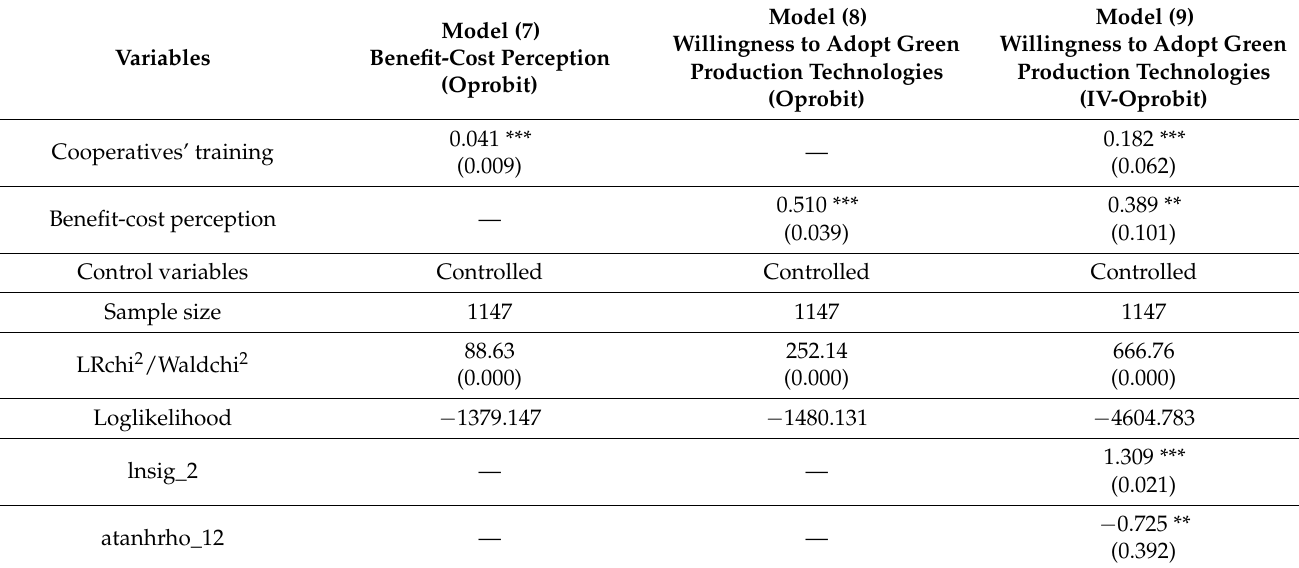
Table 6. Mediation effect of benefit-cost